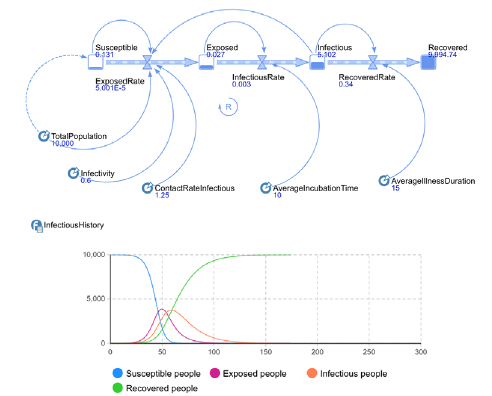
Figure 3. The Systems Dynamics approach. Source: